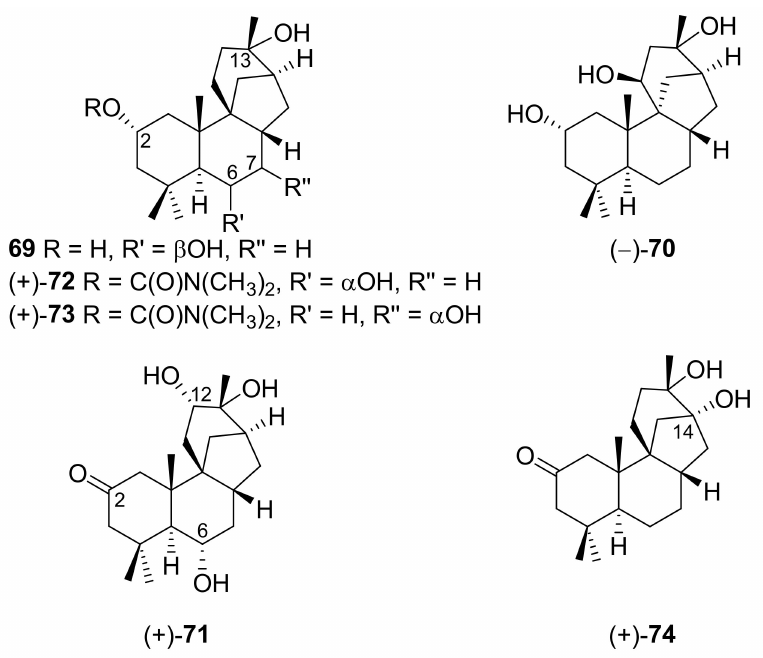
Figure 14. Stemodane diterpenoids biotransformation